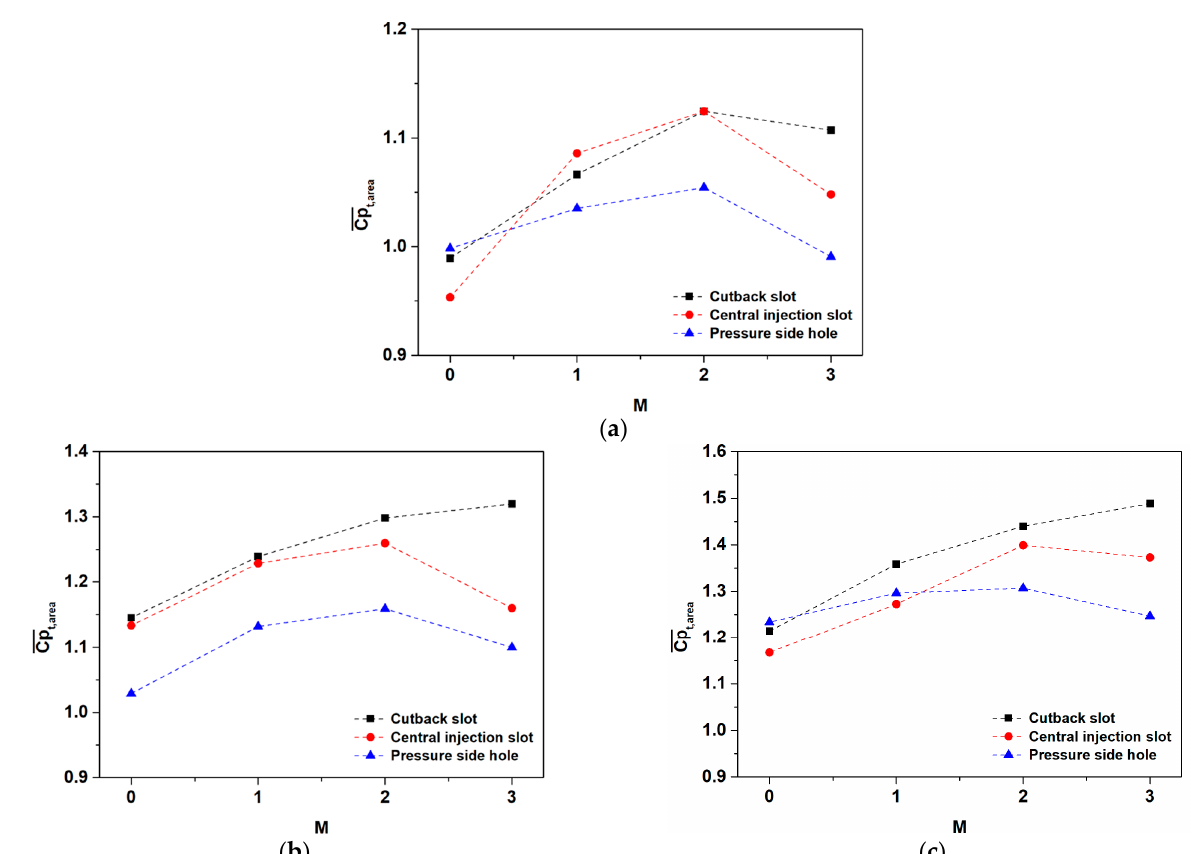
Figure 11. Area averaged total pressure loss coefficient for blowing ratios: ( a ) d TE / T = 7.5%; ( b ) d TE /T = 10.0%; ( c ) d TE /T =